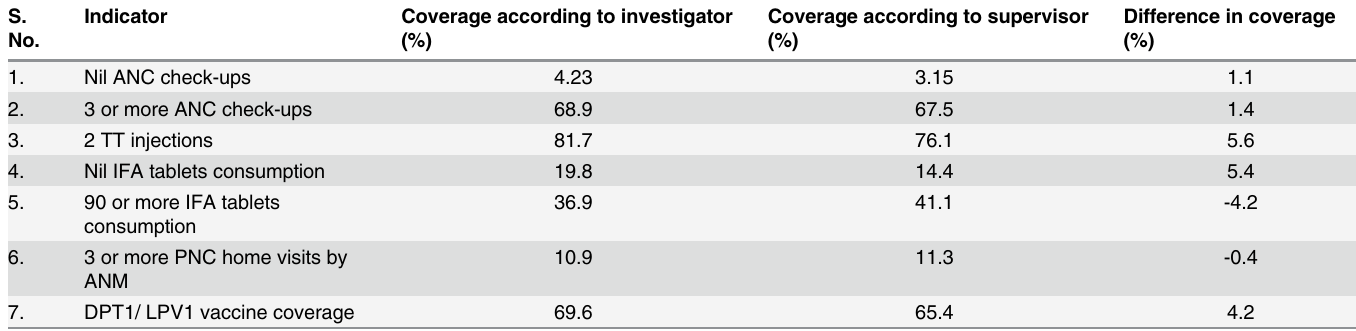
Table 5. Comparison between indicators coverage as per data collected by field investigators and supervisors. S.